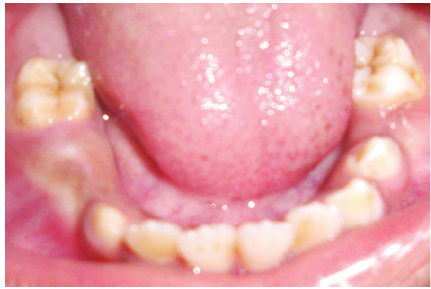
Figure 3: Showing sound tooth structure of 36 and 46 clinically without being involved with caries.